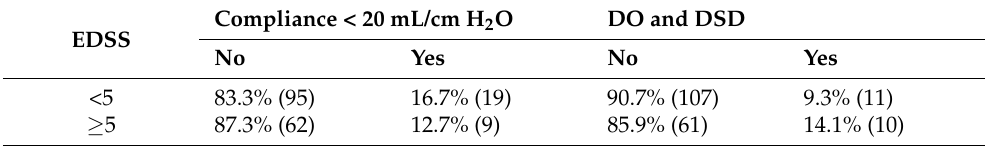
Table 4. Frequency distribution of EDSS and potential risk factors for UUTD.